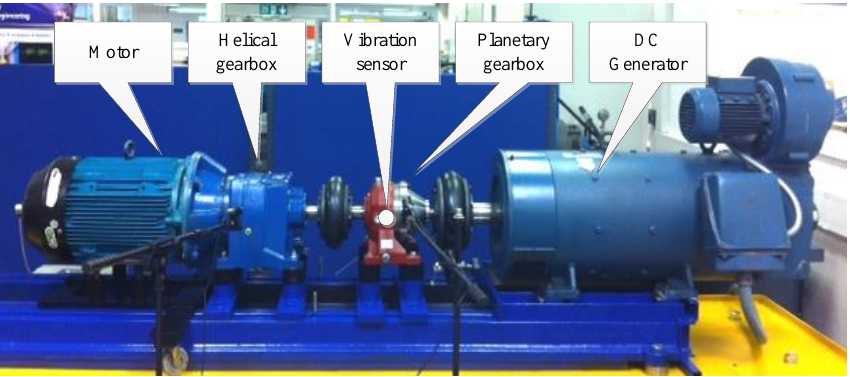
Figure 2. The planetary gearbox test rig.